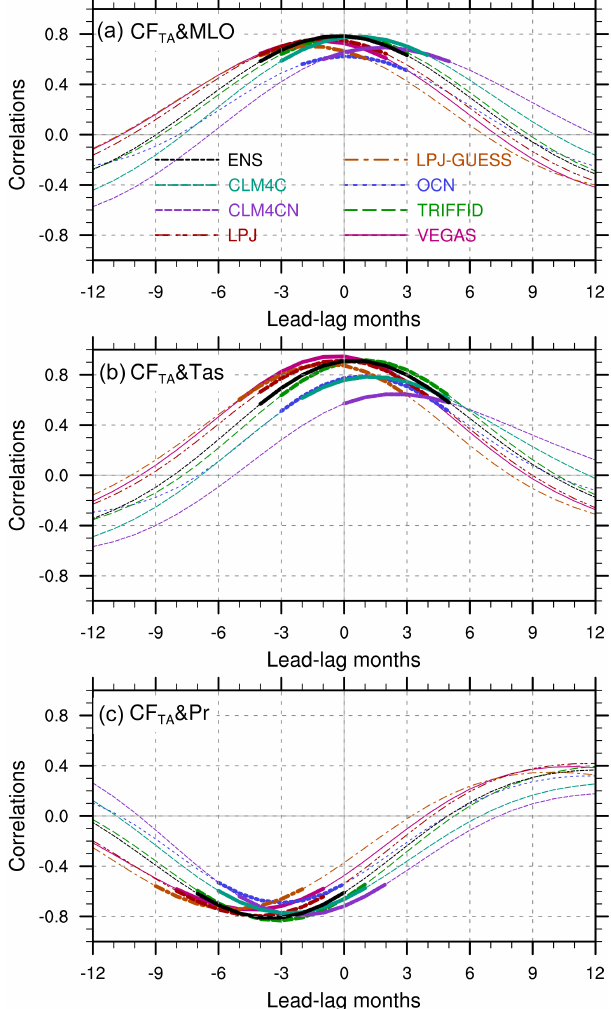
Figure 5. Color-coded correlation matrices for the interannual anomalies in the tropical CF TA and − NPP estimated by the seven terrestrial carbon cycle models. Panel (a) shows correlation coeffi- cients in pairs among the estimated CF TA , and (b) correlation co- efficients in pairs among − NPP in the period 1960–2010. Mauna Loa CGR and modeled ensemble mean (ENS) are included in these correlations as well. The values in each cell demonstrate the signif- icance levels ( p ≤ 0 . 05 refers to above 95% significance).